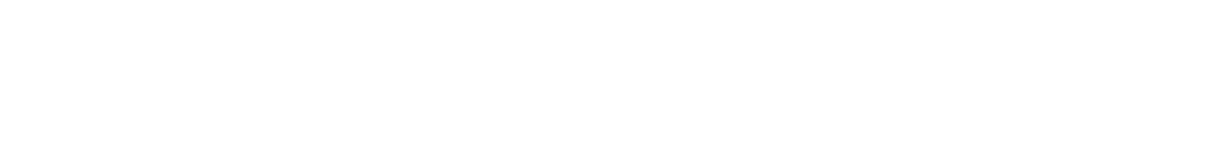
Frontiers in Mechanical Engineering |